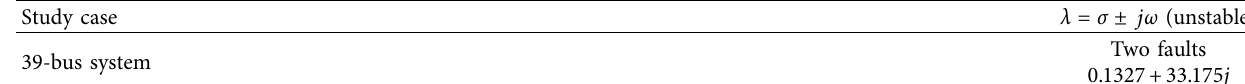
Figure 21: group of generator oscillates with the same frequency. Table 6: 39-bus system eigenvalues